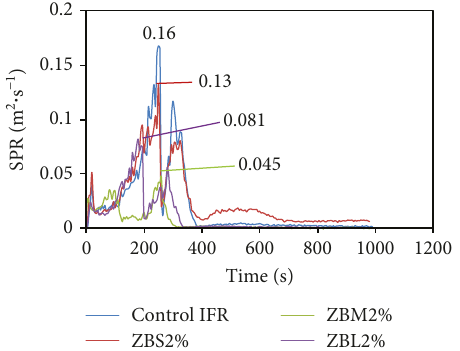
Figure 10: Smoke production rate of wood treated with IFR/ZB coatings (50 kw · m -2 ).